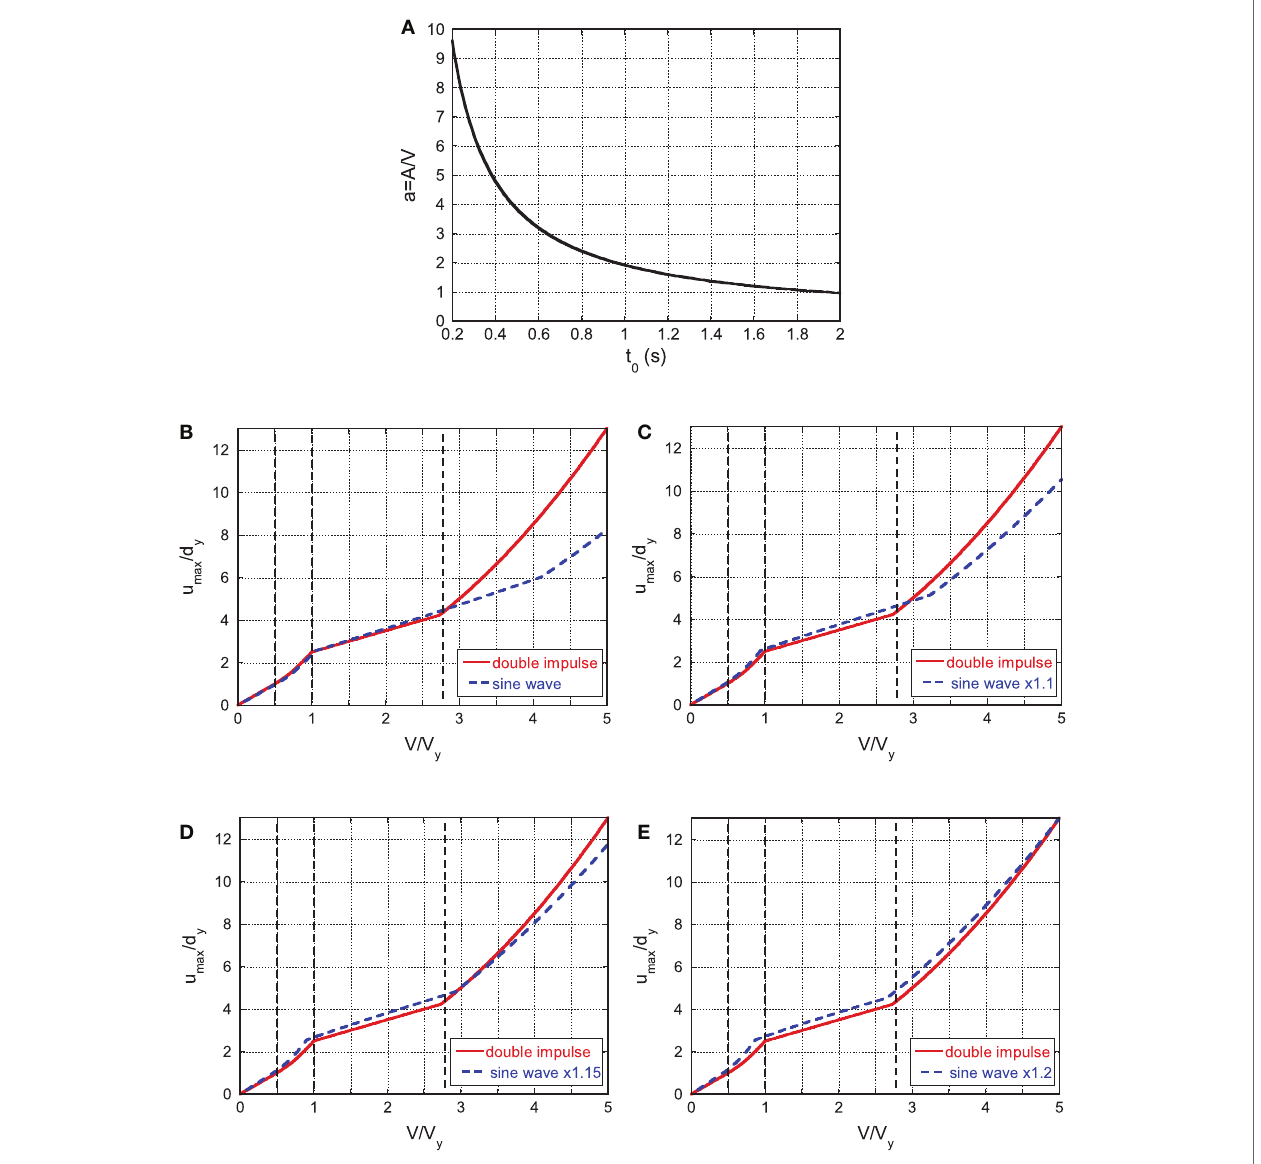
FigUre 13 | Better correspondence of maximum responses to double impulse and amplified sinusoidal inputs: (a) plot of the coefficient a with respect to the timing of the double impulse for adjusting the maximum Fourier amplitudes of the double impulse and the sinusoidal input, (B) amplification factor = 1.0, (c) amplification factor = 1.1, (D) amplification factor = 1.15, and (e) amplification factor = 1.2